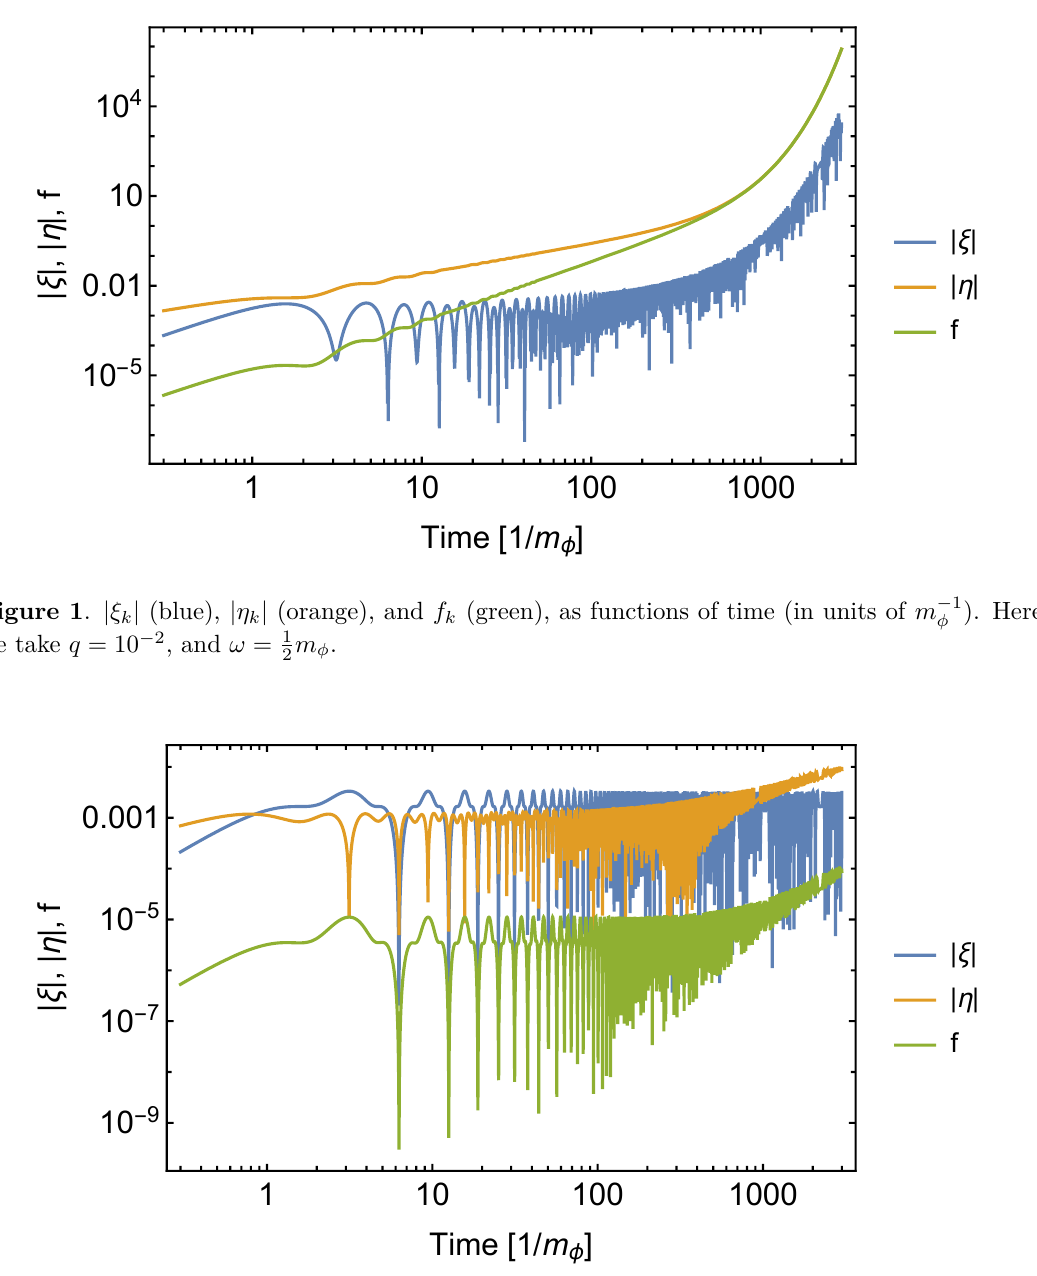
Figure 2 . Same as figure 1, except for ω = m φ